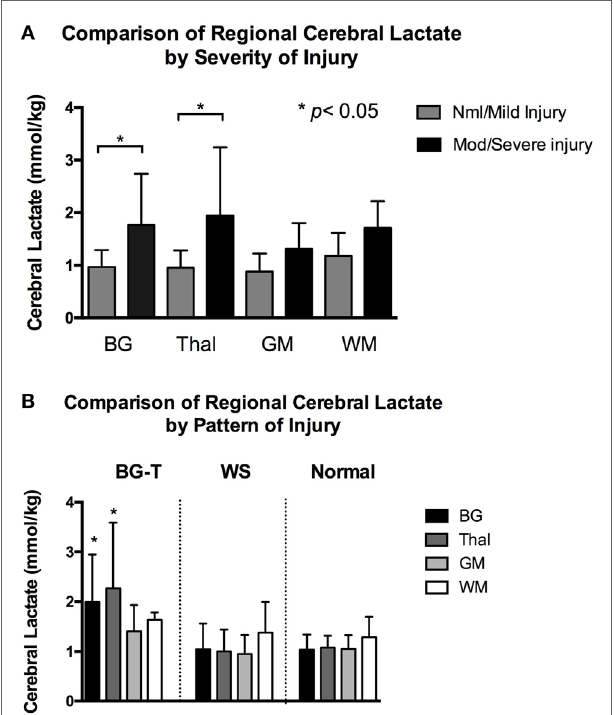
FigUre 4 | (a) Scatter plot of serum Lactate 2 vs. cerebral lactate, all patients. There is a weak correlation between serum Lactate 2 and cerebral lactate concentration, only at regions basal ganglia (BG) and Thal, shown as closed triangle and closed circle, respectively. There is no significant correlation between serum lactate and cerebral lactate at regions gray matter (GM) and white matter (WM), denoted as open square and diamond in the graph. (B) Scatter plot of serum Lactate 2 vs. cerebral lactate in infants with moderate–severe injury. For subjects with moderate–severe injury, there is a strong correlation between serum Lactate 2 and cerebral lactate at the BG, Thal, and GM region, which are denoted here in closed triangle, closed circle, and closed square, respectively. There is no significant correlation between serum lactate and WM lactate, denoted as open diamond in the graph.